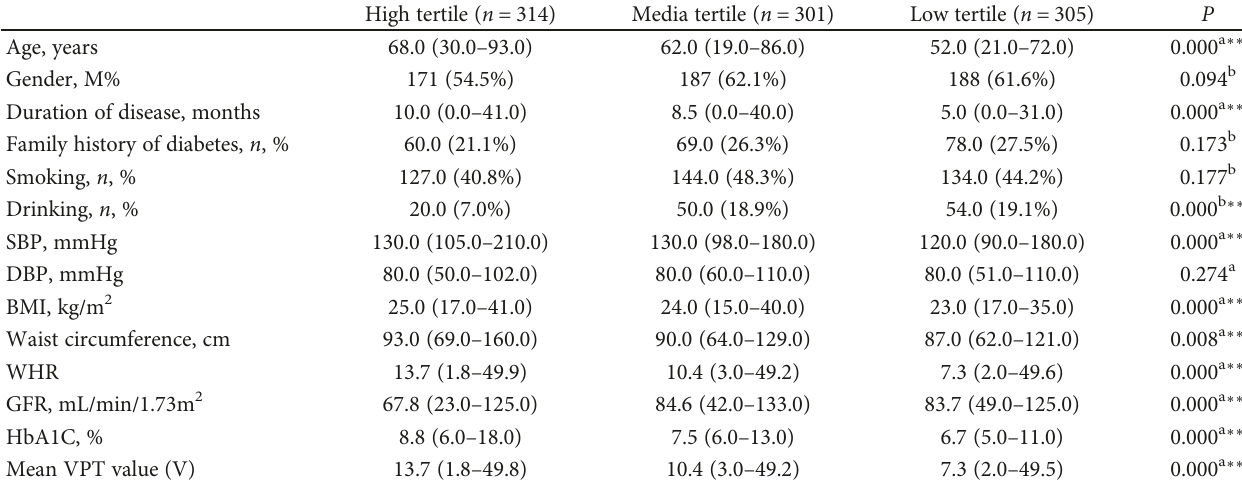
Table 1: Baseline characteristics of 920 T2DM patients strati fi ed by SUDOSCAN-CAN value.